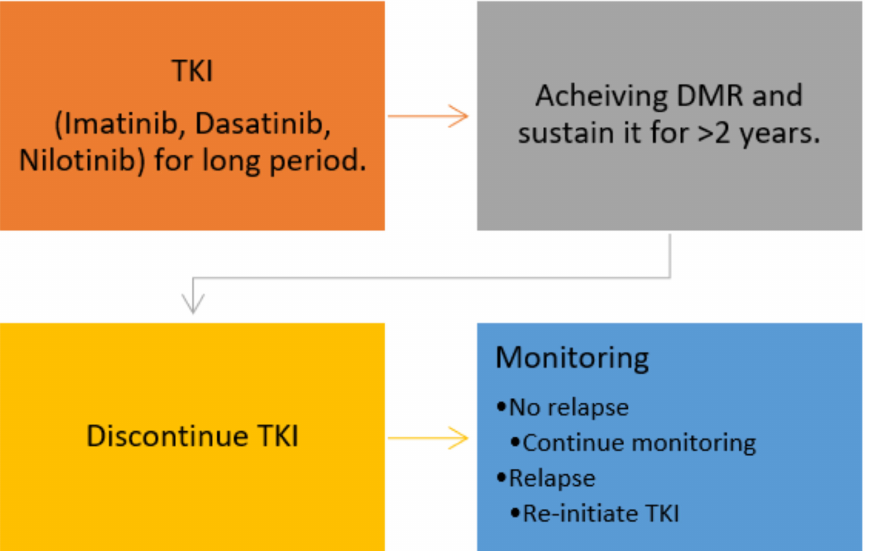
Figure 2. TFR concept, patients achieving DMR after long-duration on TKI can attempt for TFR, with continuous monitoring, those who relapse will re-initiate the treatment. Abbreviations: TKI = tyrosine kinase inhibitor, DMR = deep molecular response, and TFR = treatment-free